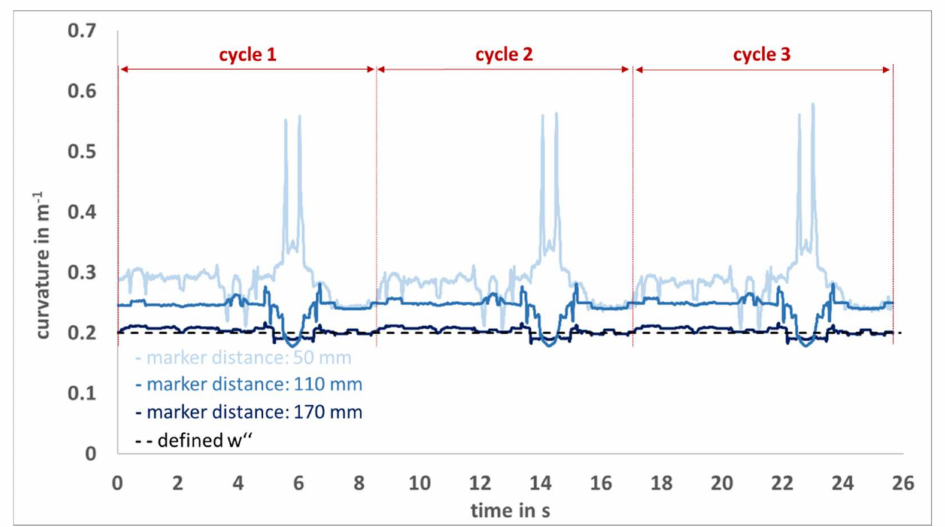
Figure 6. The Qualisys system signal at v fast are shown in light blue (marker distance: 50 mm), blue (marker distance: 110 mm) and dark blue (marker distance: 170 mm). For all three signals, the defined curvature of the calibration profile was 0.2 m − 1 (black broken